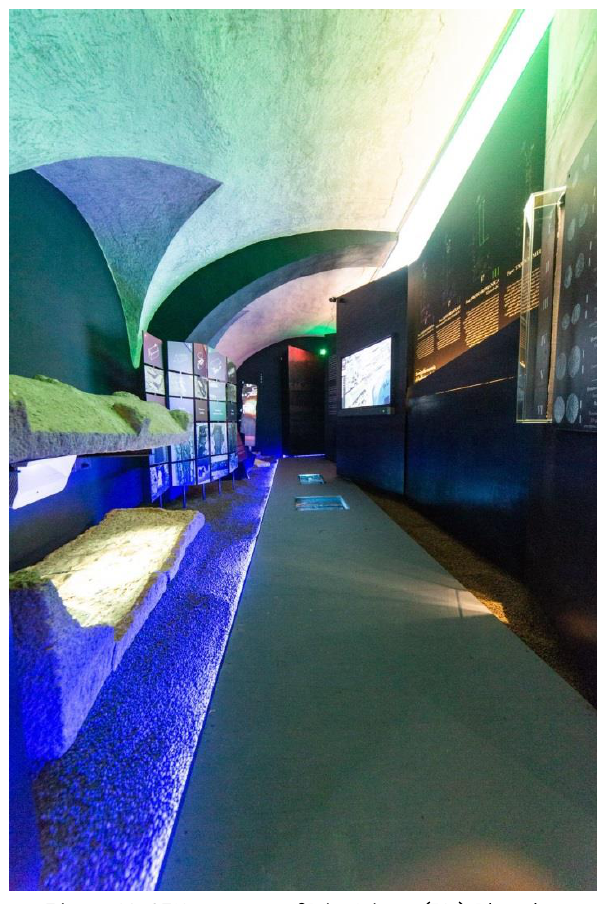
Figure 12. SEM, comune of Riva Ligure (IM). Photo by Alessandro